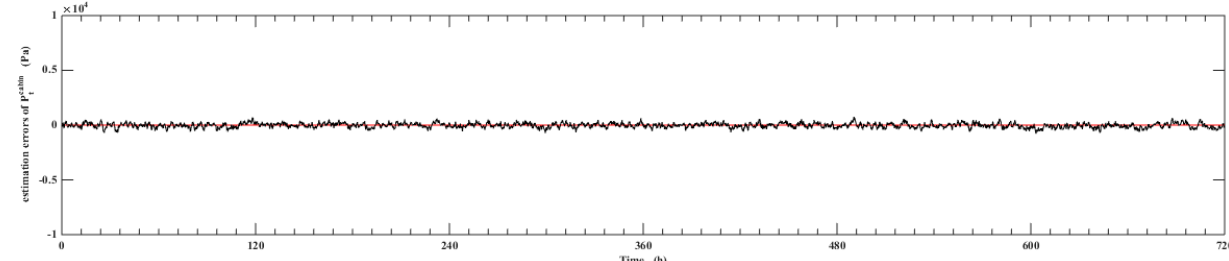
Figure 7. Estimated error of total pressure in cabin.